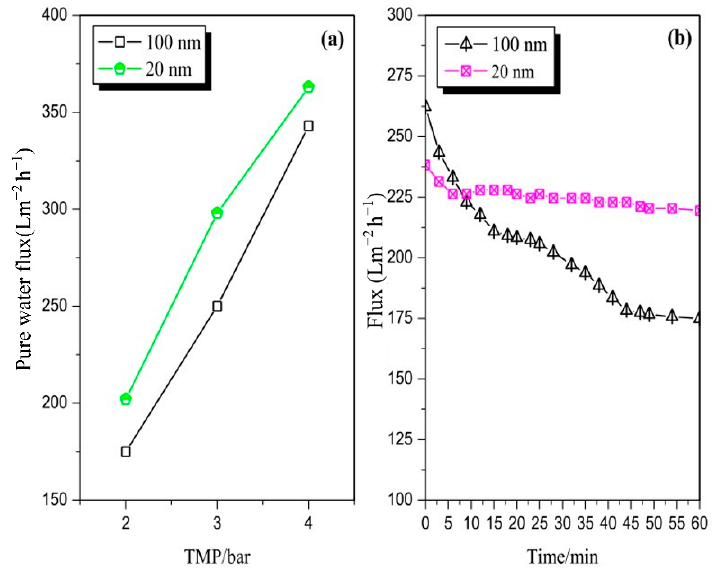
Figure 2. ( a ) The pure water flux comparison between 100 and 20 nm membranes under different operating conditions; ( b ) the flux of 100 and 20 nm membranes by filtered pretreated mixed juice (TMP of 3 bar, CFV of 3 m/s, and temperature of 70